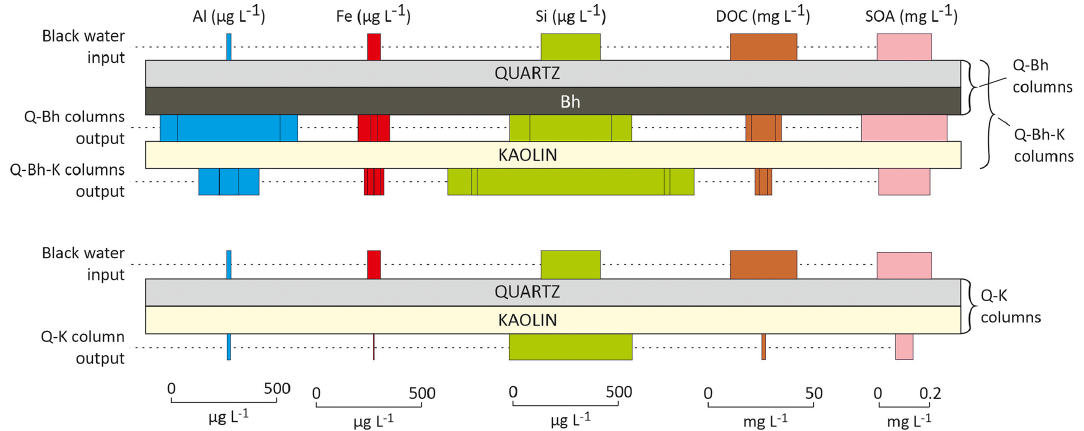
Figure 3. Representation of the concentrations measured during the column experiments. The width of the colored blocks represents the concentration of the solute. SOA – small organic